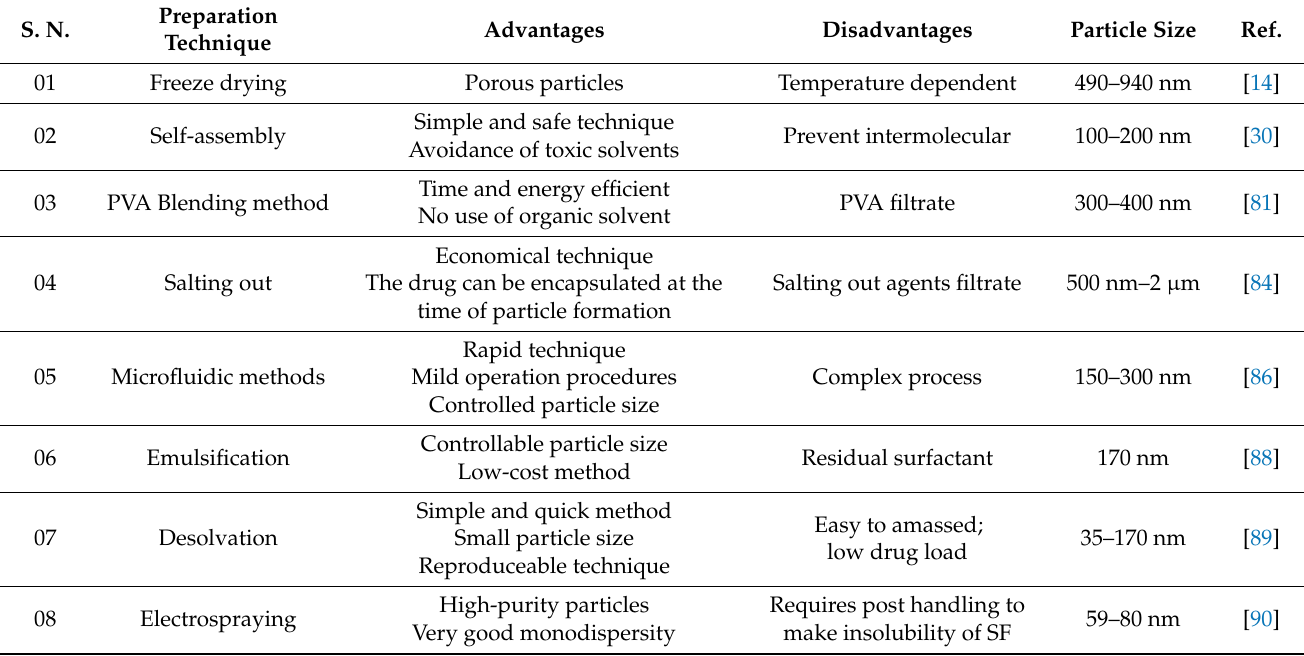
Table 1. Preparation method of silk fibroin (SF) micro- and